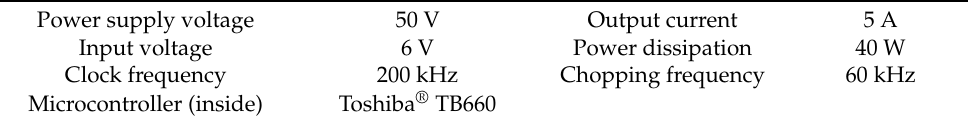
Table 3. HY-DIV268N-5A driver features